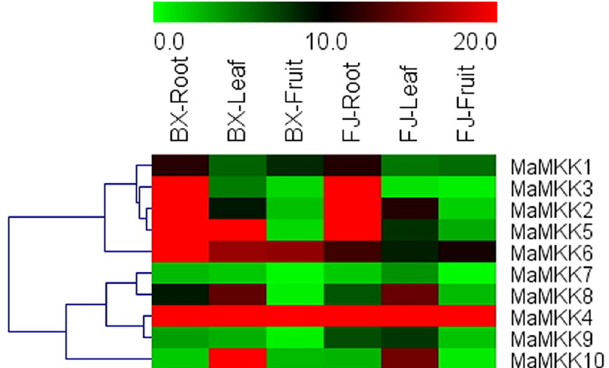
Figure 5. Expression profiles of banana MAPKKs in roots, leaves and fruits of BX and FJ. The heat map was constructed according to the FPKM value of banana RNA-seq data. Changes in gene expression are shown in color as the